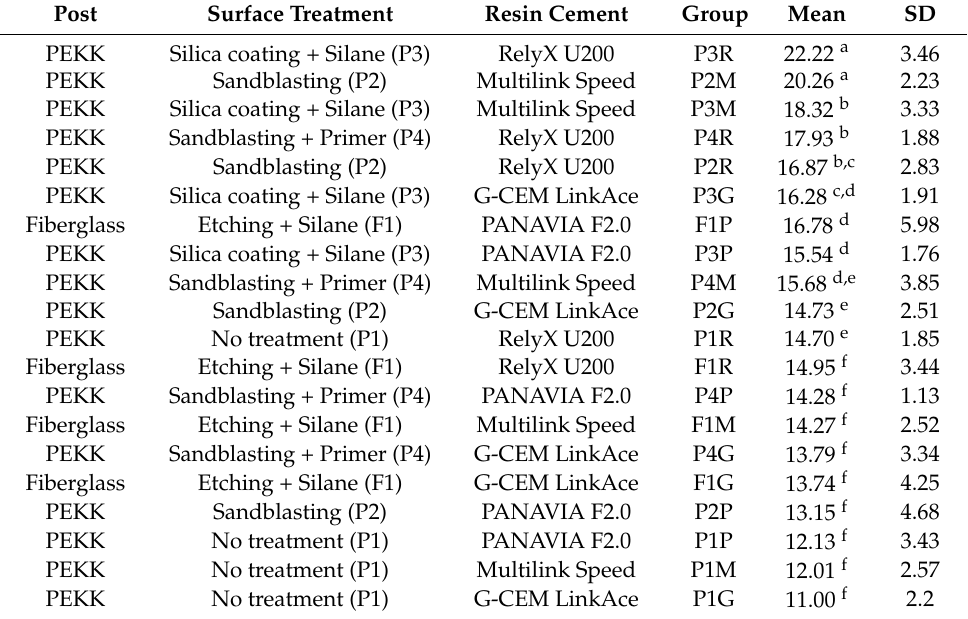
Table 3. The results of the microtensile bond strengths test